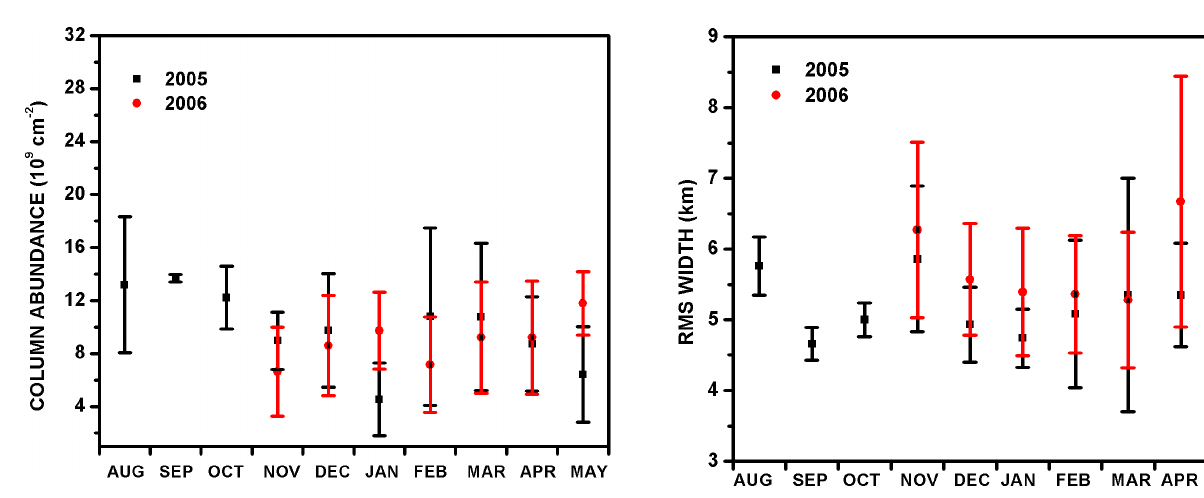
Fig. 7c. Same as Fig. 7a, but for RMS